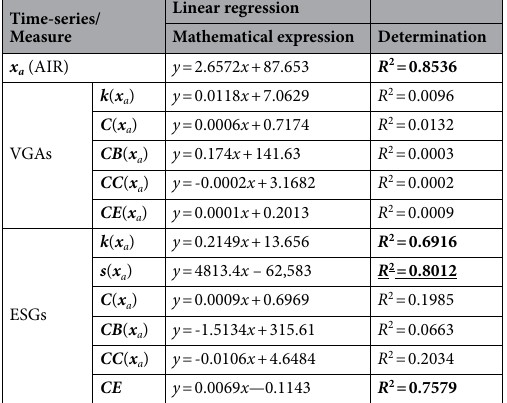
Table 3. Linear regression fittings for the X a (Air) time-series. Cases shown in bold indicate high (> 0.65) coefficients of determination. Underlined cases highlight the max coefficient, in total.